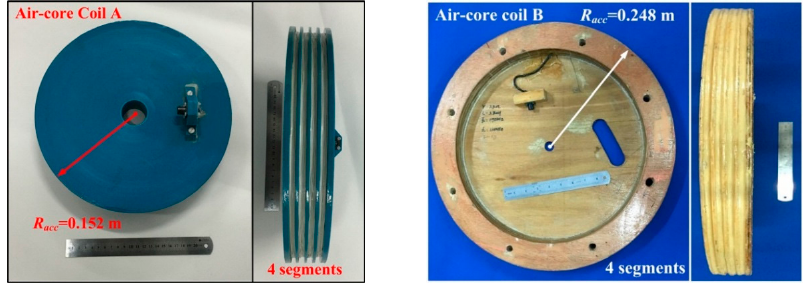
Figure 11. Two air-core coils.